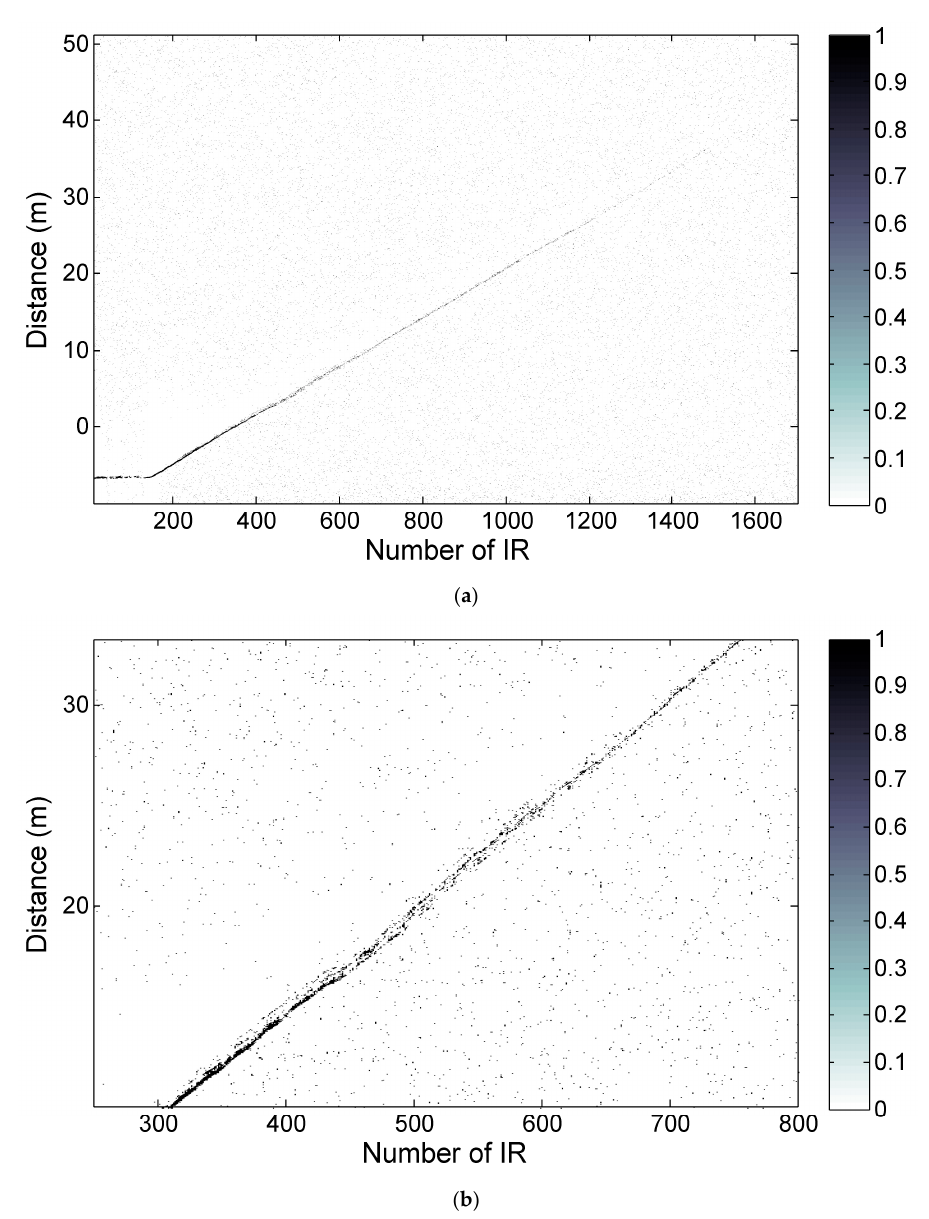
Figure 8. Detection of a moving person by 15th-order M-sequence SoC radar, maximum distance 41 m: ( a ) entire range of interest; ( b ) detail of trace fade-out at approximately30 m.